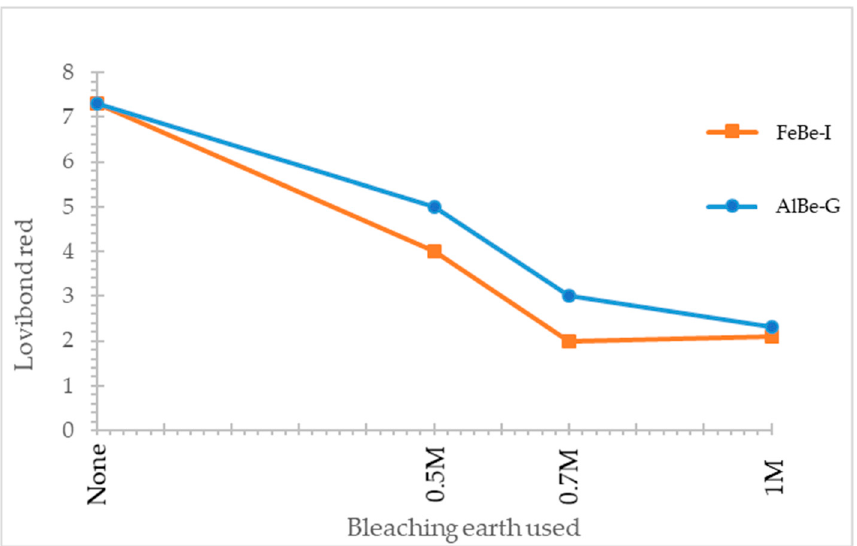
Figure 11. Red colour values before and after bleaching tests with oxalic acid activated bentonites in soybean oil (80 °C, t = 30 min, 250 rpm, 3% w / w ).